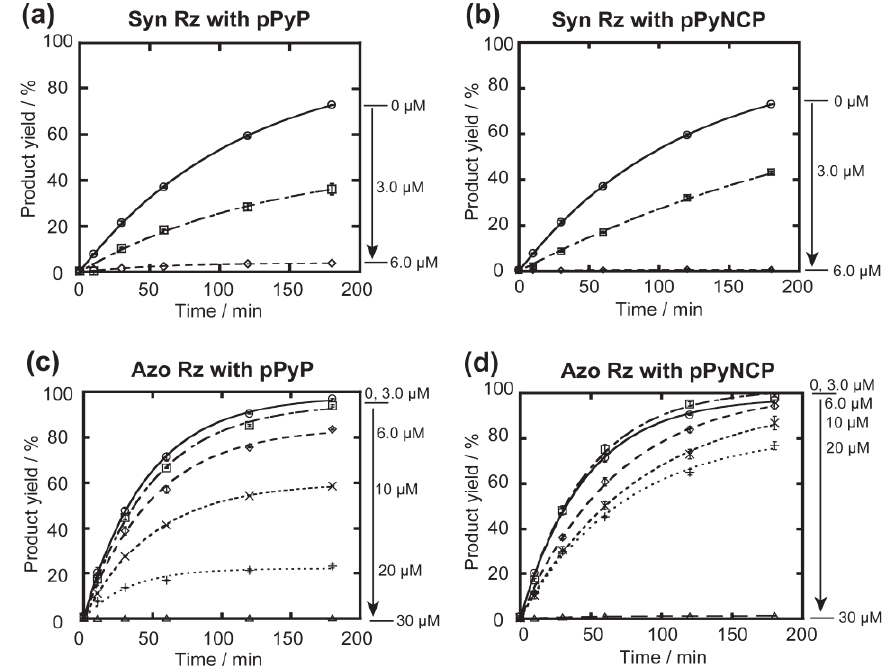
Figure 3. Effects of cationic porphyrins on the GTP-dependent cleavage reactions